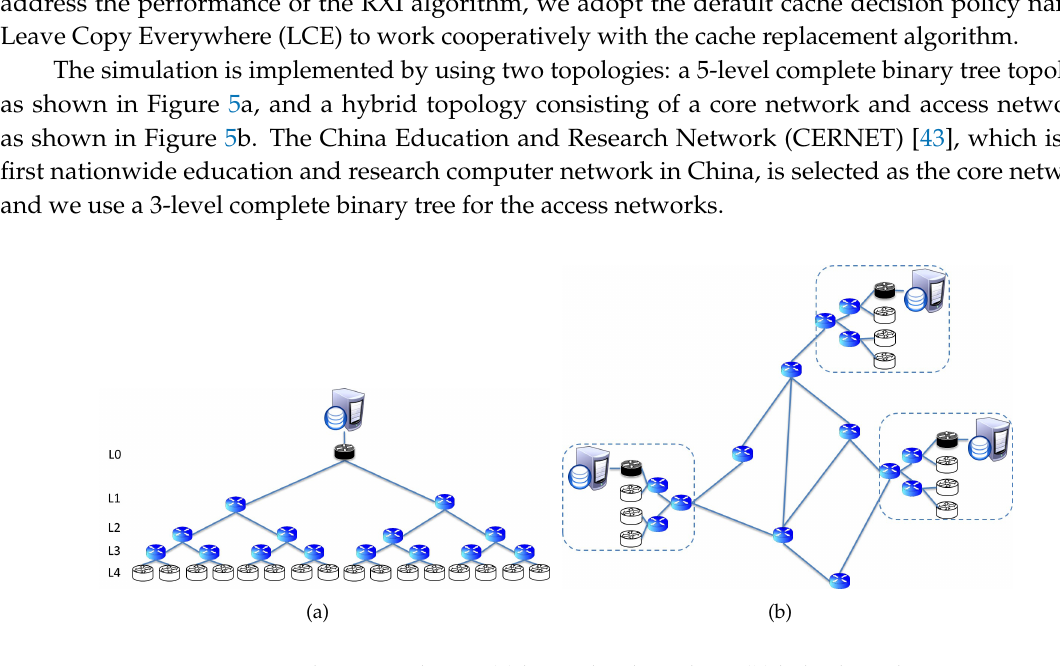
Figure 5. Simulation topologies. ( a ) hierarchical topology; ( b ) hybrid